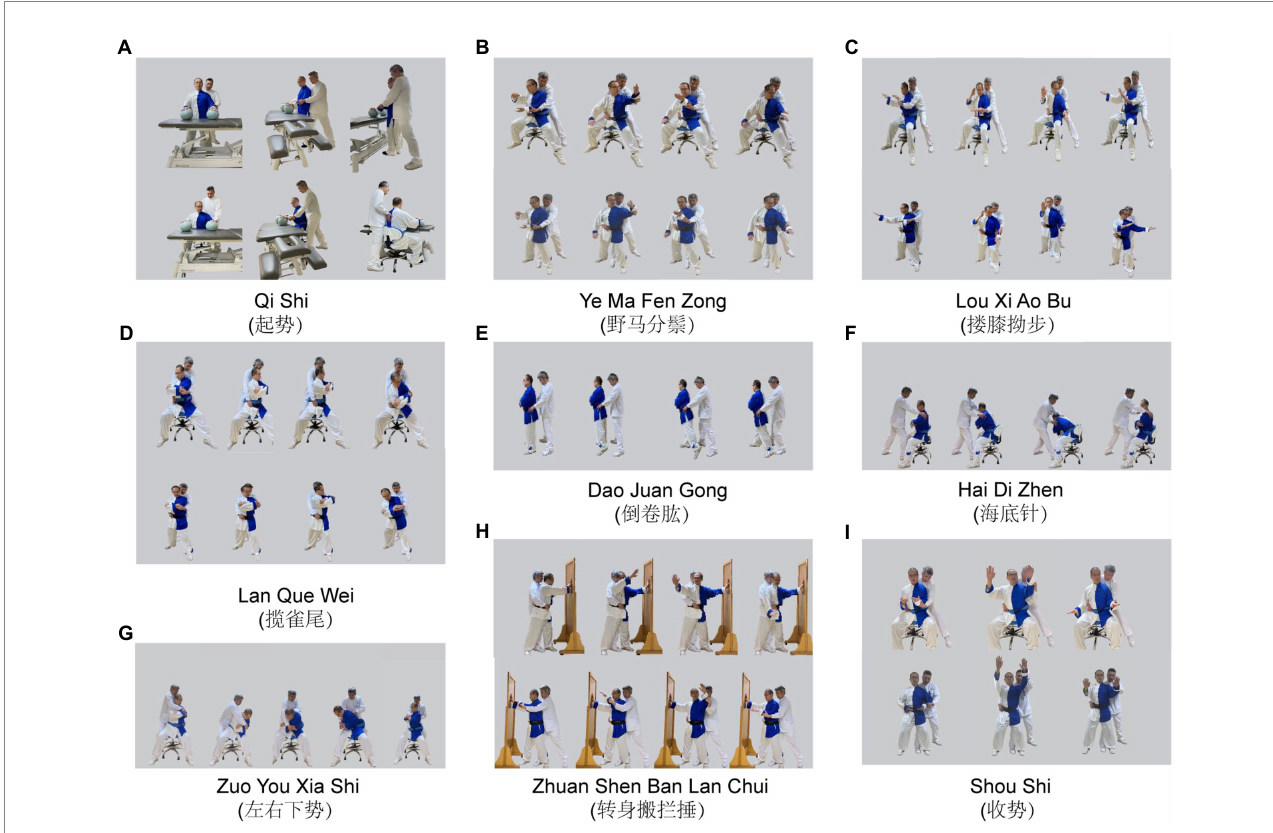
FIGURE 1 Experimental group (WAT). Two position are applied in the WAT. (1) Sitting position: The patient sits on the swivel chair with fixed chassis with a protective belt or regular chair. Legs slightly wider than shoulders apart. The toe is in line with knee joint. Hold body erect and gaze attending to the main hand. (2) Standing position: lunge position (left): The patient stands with two feet shoulder-width apart, then the right foot externally rotates at 45⁰, weight shift to the right, left foot takes a step forward with the knee facing forward. The therapist stands behind the patient, placing his knee against the popliteal fossa on the affected side (left) and assisting the patient to stand in a lunge with a slight bent